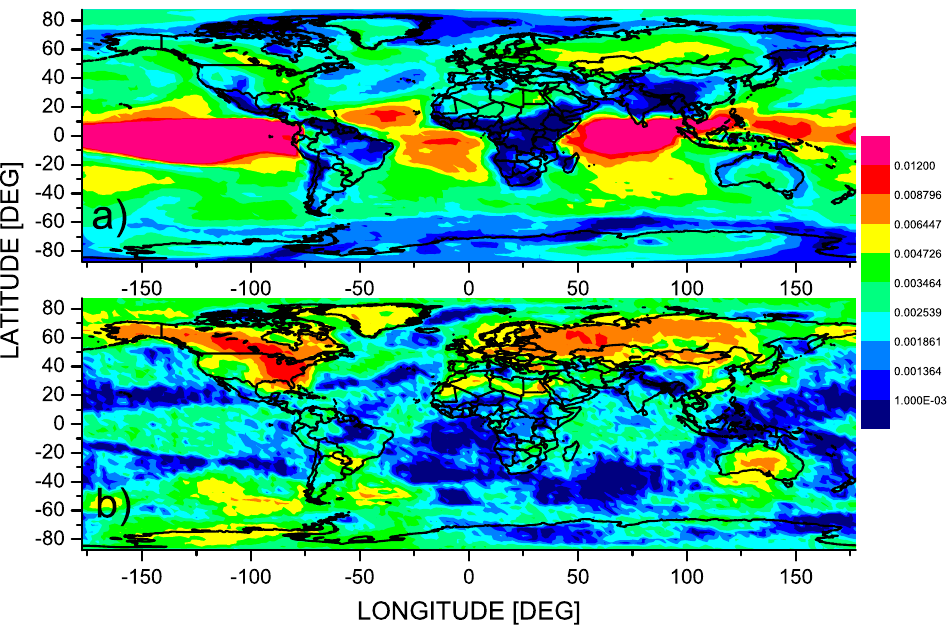
Fig. 4. Area weighted connectivity for SATA climate networks with density % = 0 . 005 obtained by uniform thresholding of the absolute correlations (a) and of the absolute correlation Z -scores related to independent univariate FT surrogate data (b)